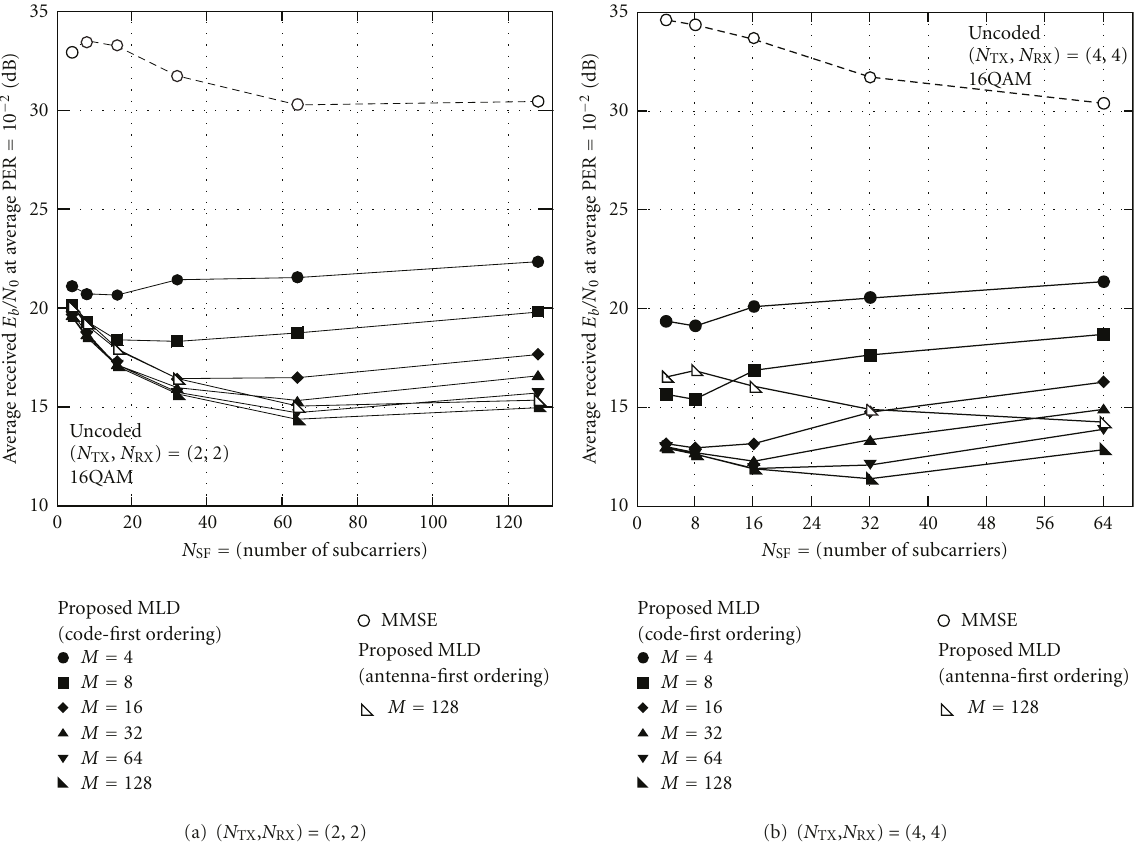
Figure 6: Required average received E b /N 0 as a function of N SF (uncoded